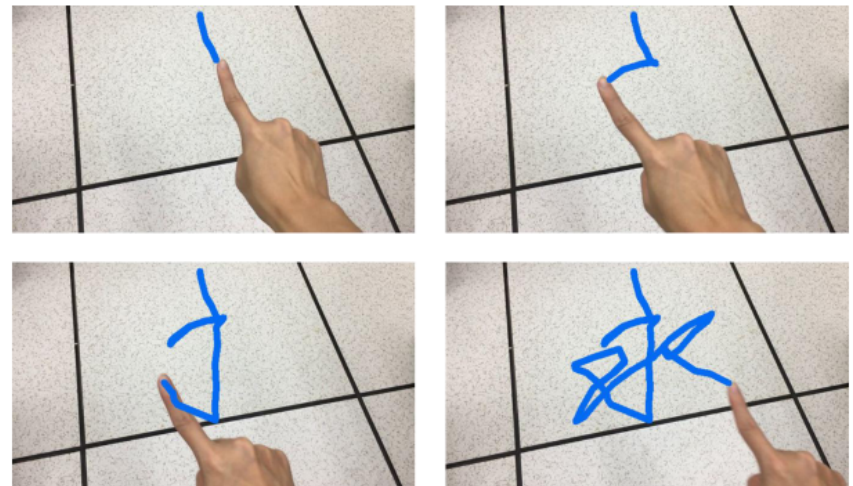
Figure 15. Testing characters for air-writing: We connect the fingertip coordinates to form the fingertip trajectories.